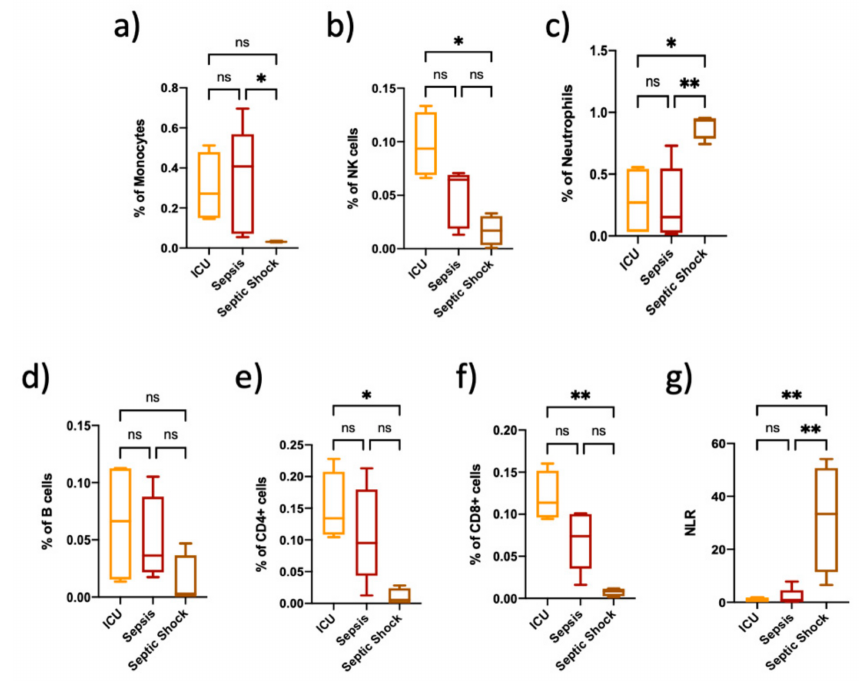
Figure 1. Estimation of the immune sub-population in critically ill, septic and septic shock patients; ( a – f ) Immune cell subpopulations estimated using a process of deconvolution based on discriminating differentially methylated regions (DMRs) specific to each cell type; ( g ) Neutrophil to lymphocyte count ratio (NLR) in ICU, sepsis and septic shock patients. Estimates were obtained from DNA methylation data from critically ill non-septic patients ( n = 4), septic ( n = 7) and septic shock ( n = 4) patients. Data are expressed as mean ± SEM). ns = non-significant. p value; * p < 0.05; ** p < 0.01. The lines at the top of the box plots indicate differences between compared conditions.